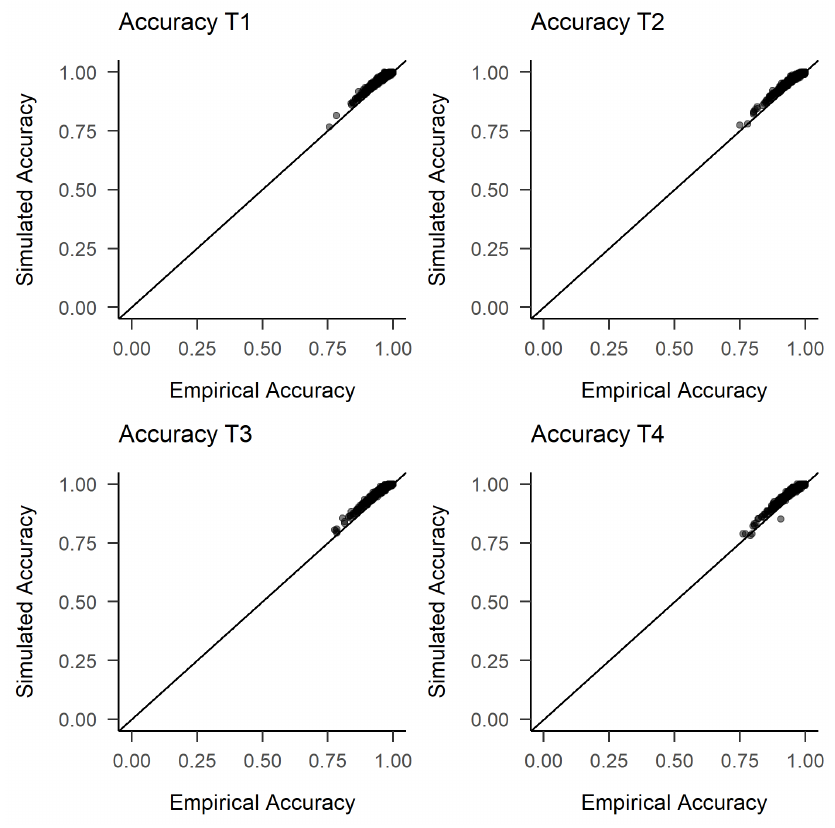
Figure A4. Posterior predictive checks of accuracy rates for all time